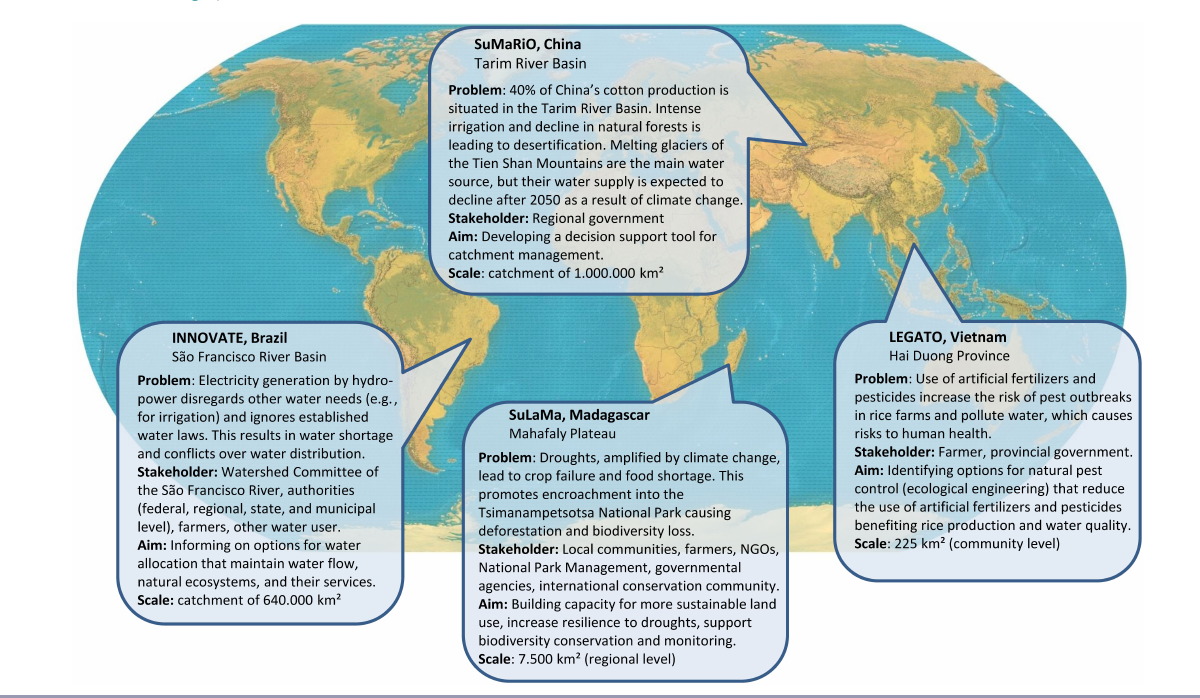
Fig. 1 . Case studies of the Sustainable Land Management Program (Eppink et al. 2012) for which the problem- oriented approach was developed and exemplified. Videos summarizing each case study can be accessed at the Program’s website (URL: http://modul-a.nachhaltiges-landmanagement.de/de/mediathek-modul-a/